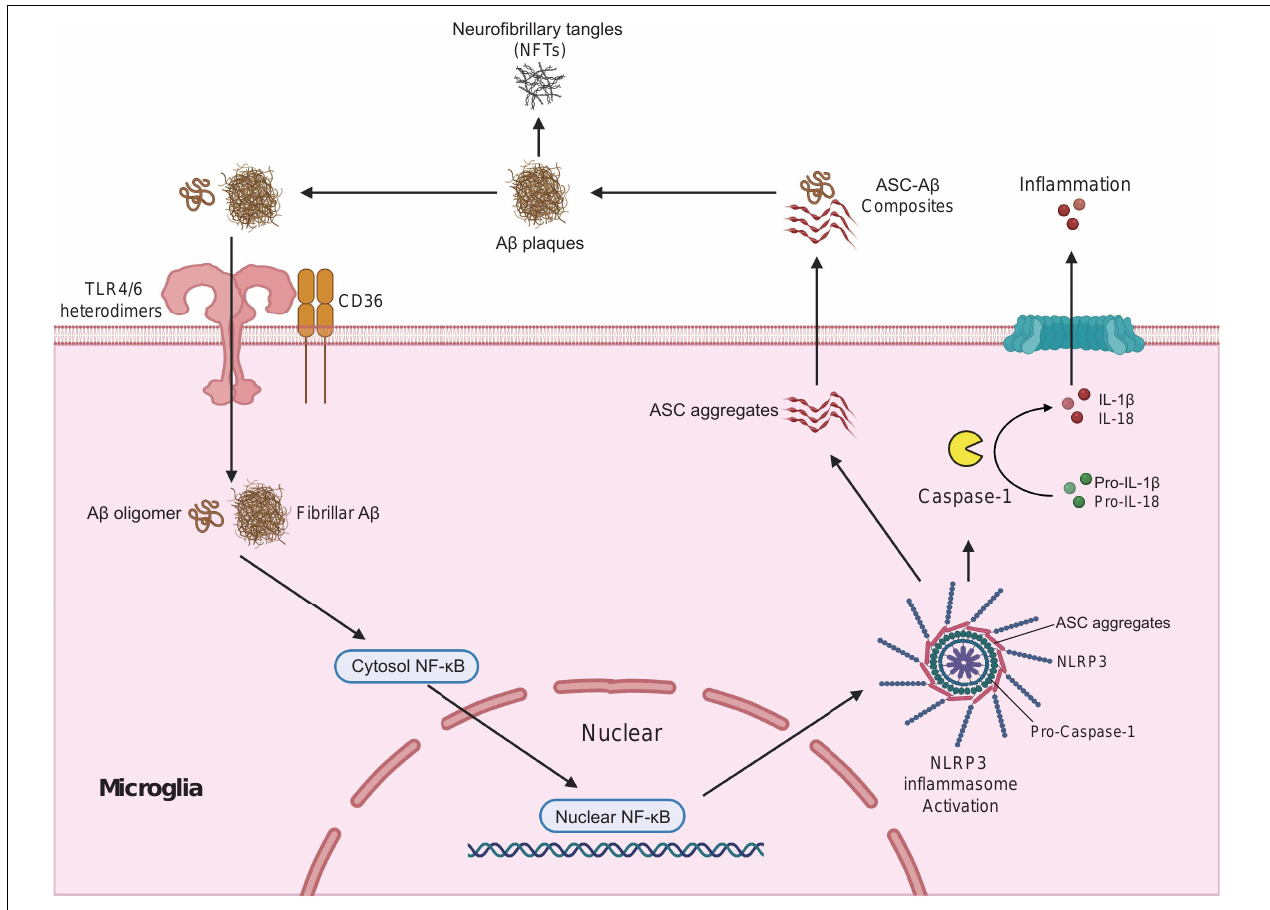
FIGURE 2 | Microglia modulates A β plaques and neurofibrillary tangles (NFTs) formation via the activation of NLRP3 inflammasome. NLRP3 inflammasome is a multimeric protein complex that comprises a sensor protein NLRP3, an adaptor protein apoptosis-associated spec-like protein containing a CARD (ASC), and an effector protein caspase-1. In AD conditions, microglial surface receptors CD36 cooperates with TLR4-TLR6 heterodimers to recognize and internalize the A β oligomers and fibrils, which induces translocation of nuclear factor κ B (NF- κ B) from the cytosol to the nucleus, and the subsequent activation of NLRP3 inflammasome. Activation of NLRP3 inflammasome leads to the formation of the adaptor proteins ASC aggregates, which bridge the sensor protein NLRP3 and activated the effector protein from pro-caspase-1 to active caspase-1. Activated caspase-1 cleavage of pro-IL-1 β and pro-IL-18 into active pro-inflammatory cytokines IL-1 β and IL-18. In addition, the speck-like aggregates of ASC proteins could be released to extracellular space and bound to the surrounding soluble A β led to the formation of ASC-A β composites. The formation of ASC-A β composites promoted the A β aggregation and served as a major driver for the formation of